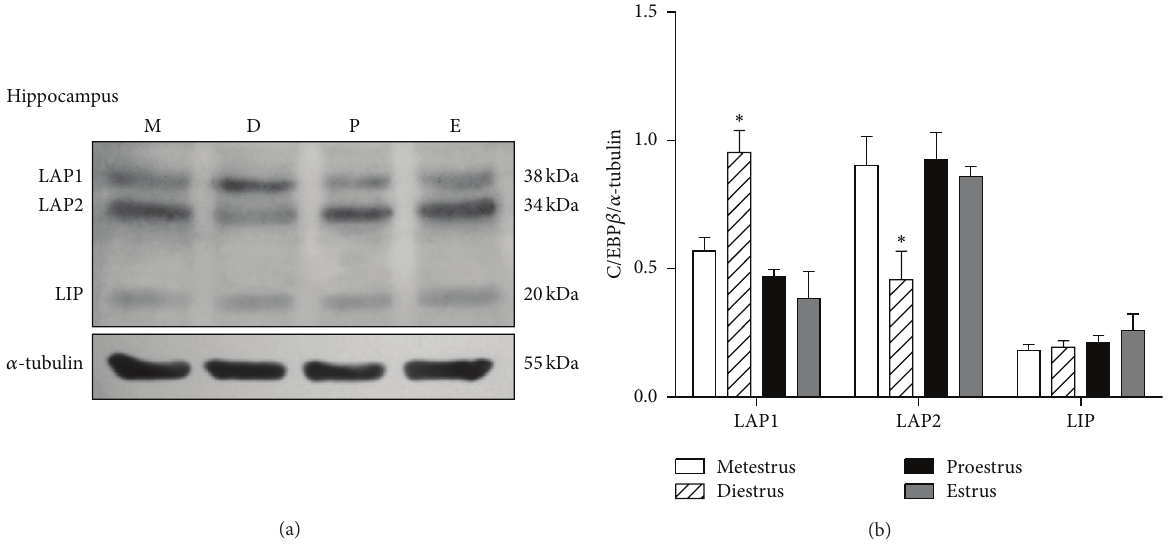
Figure 3: C/EBP 𝛽 isoforms content in the rat hippocampus along the estrous cycle. (a) A representative western blot for the three isoforms during metestrus (M), diestrus (D), proestrus (P), and estrus (E). (b) Densitometric analysis of LAP1, LAP2, and LIP content relative to that of 𝛼 -tubulin. The data represent the mean ± S.E.M, 𝑛 = 6 , ∗ 𝑃 < 0.05 LAP1 and LAP2 diestrus versus all the other